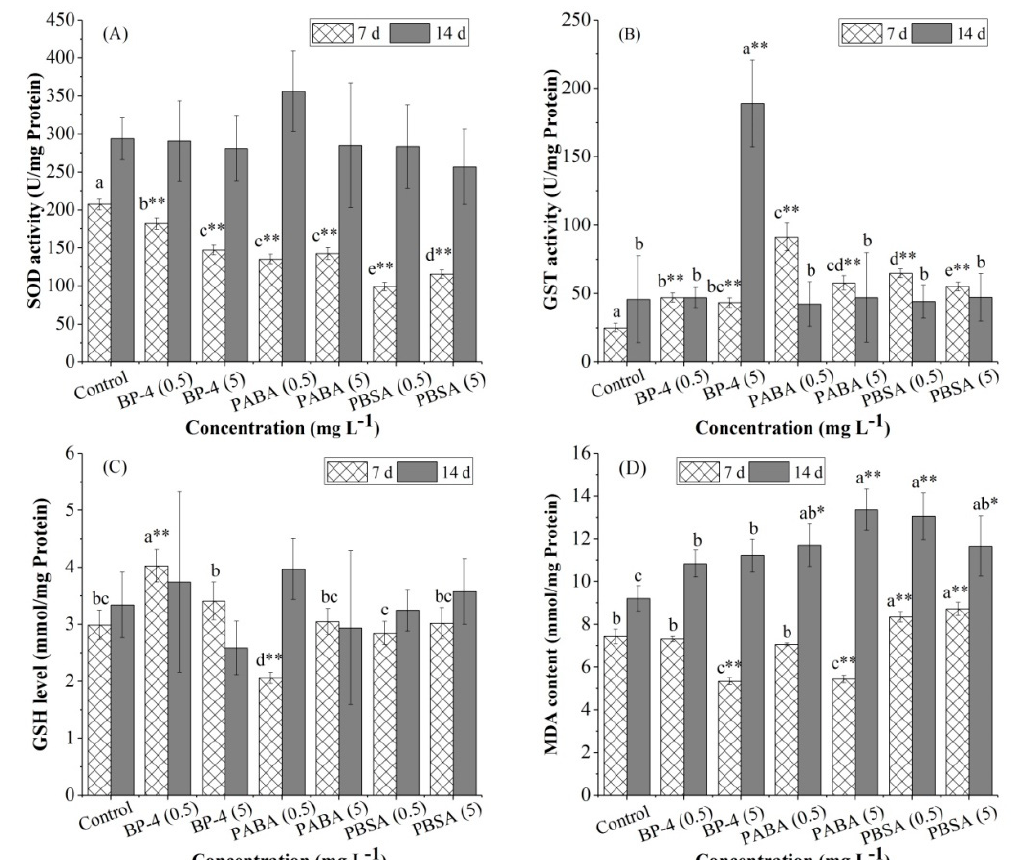
Figure 2. Effect of exposure to BP-4, PABA, or PBSA (0.5 and 5 mg L − 1 ) for 7 and 14 days on the activity of biochemical indicators ( A , SOD; B , GST; C , CSH; D , MDA) in zebrafish liver. Data are expressed as means ± SD, n = 3 for each data point. Superscript letters a–e indicate differences among the experimental treatments at the same exposure time. * Significantly different from controls ( p < 0.05), ** Highly significantly different from controls ( p < 0.01).